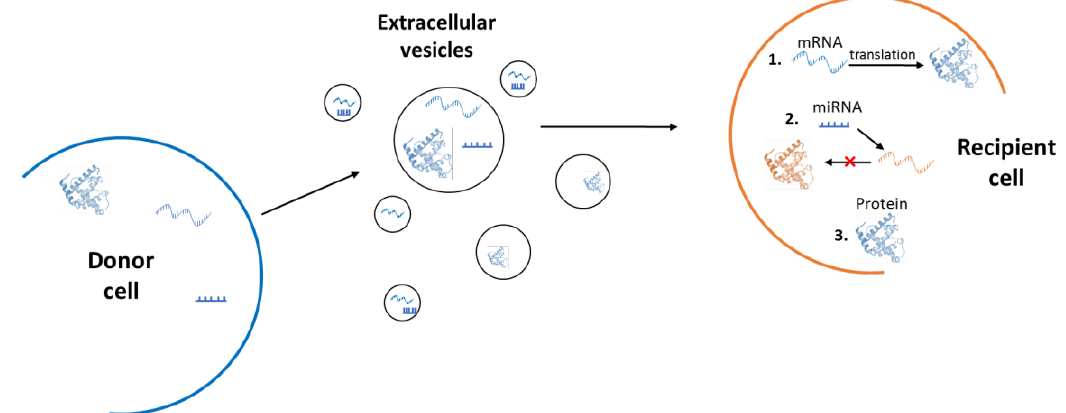
Figure 2. Extracellular vesicle mechanisms of action. Extracellular vesicles can confer functional changes and alter the phenotype of recipient cells through the action of their molecular payload. This involves: 1. extracellular vesicle mRNA translation within the recipient cell cytoplasm, 2. regulation of gene expression mediated by extravesicular miRNA, and 3. direct extracellular vesicle protein action.